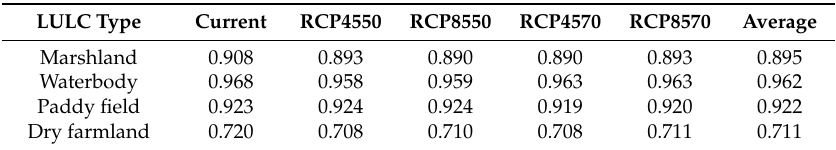
Table 7. The AUC for the four LULC types predicted with different climate scenarios by the Maxent model.